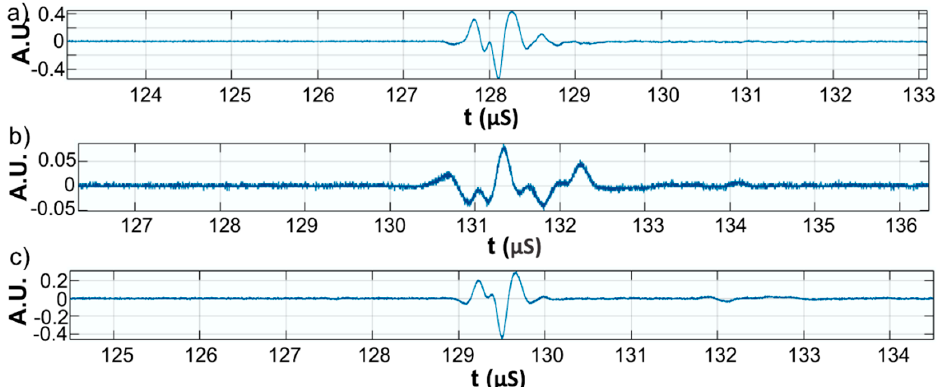
Figure 11. Zoomed second echo for: Wi ( a ); WZn ( b ); and Wd ( c ).